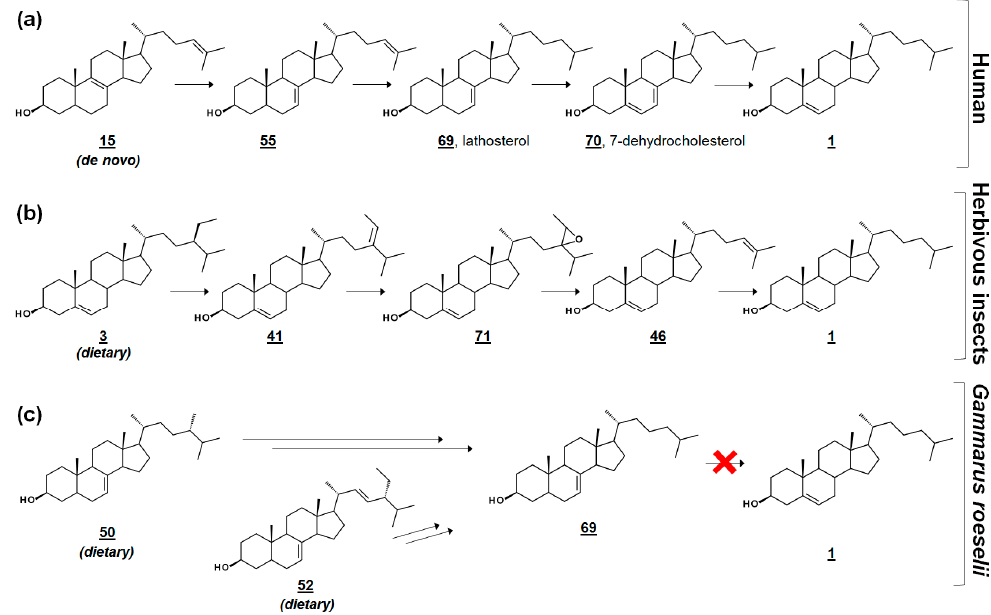
Figure 5. Comparative cholesterol biosynthesis between humans and arthropods. ( a ) Late-stage cholesterol biosynthesis in humans from de novo zymosterol 15 . ( b ) Proposed synthesis of cholesterol in herbivorous insects via dealkylation of dietary plant sterols (sitosterol) [58]. ( c ) Amphipod Gammarus roeselii can dealkylate the side chain of ∆ 7 algal sterols, such as fungisterol and chondrillasterol, but cannot produce cholesterol [56].